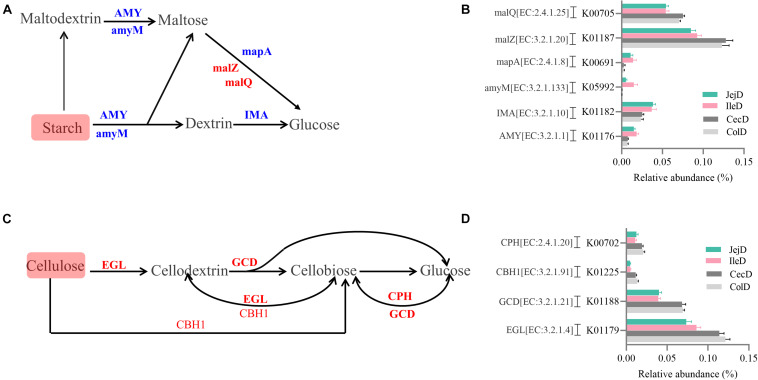
Differences in the metabolic processes of starch and cellulose degradation between the small and large intestines. Overview of the degradation process for starch (A) and cellulose (C) to glucose. Comparison of the KEGG orthology (KO) genes that differ significantly in abundance in starch (B) and cellulose (D) degradation between the small and large intestines. Red and blue fonts indicate that the change in abundance of this KO gene was higher or lower, respectively, in the large intestine compared with the small intestine.